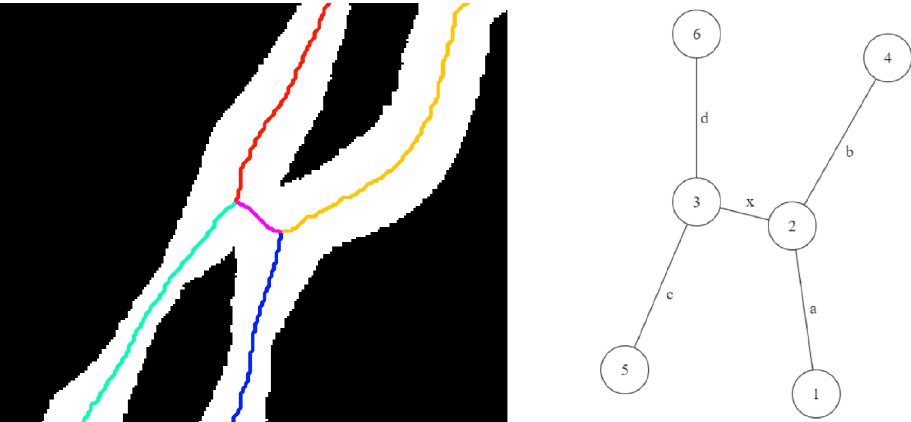
Figure 10. Illustration of tangential-contact: ( left ) skeleton; ( right ) skeleton-graph representation.